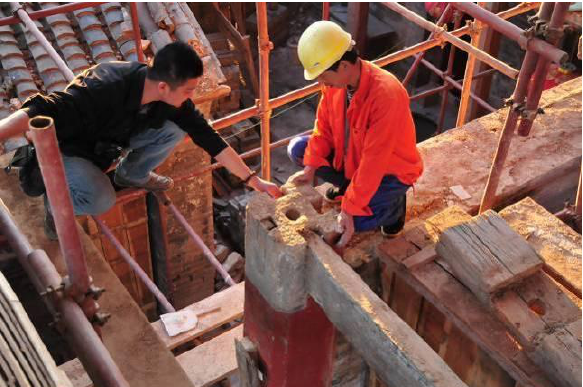
Figure 12 beam not really comes out at the